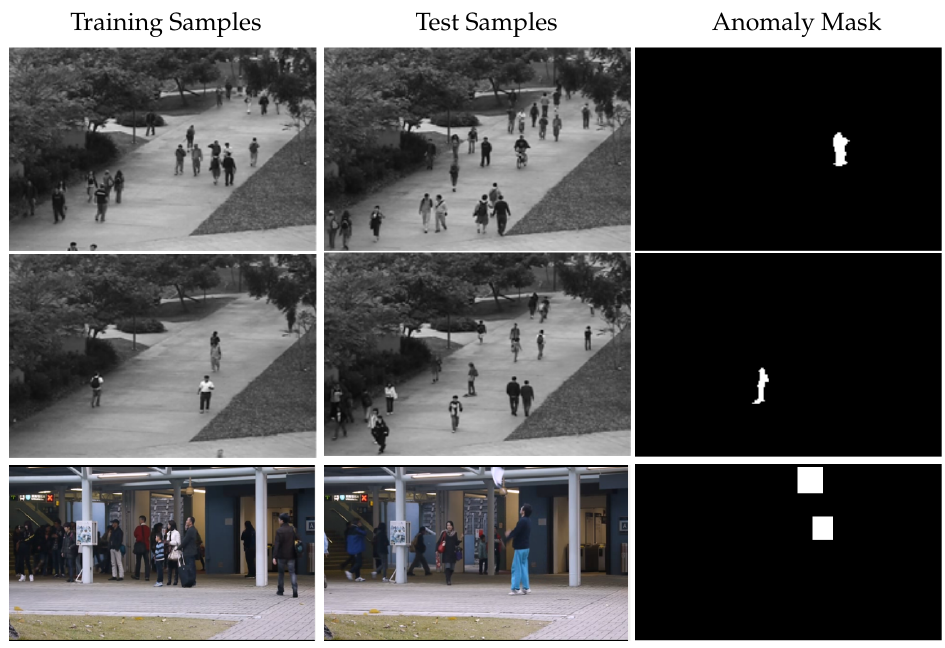
Figure 1. UCSD dataset ( top two rows ): Unlike normal training video streams, anomalies consist of a person on a bicycle and a skating board, ground truth detection shown in anomaly mask. Avenue dataset ( bottom row ): Unlike normal training video streams, anomalies consist of a person throwing papers. Other examples include walking with an abnormal object (bicycle), a person running (strange action), and a person walking in the wrong